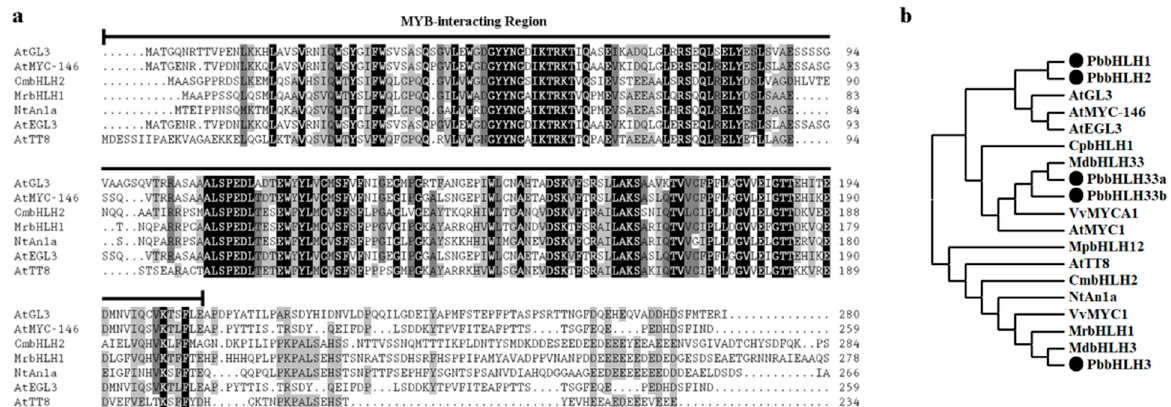
Figure 1. Analysis of IIIf bHLHs. ( a ) Multiple sequence alignment of the MYB-interacting region (MIR) domain of the IIIf bHLH transcription factors. Identical residues and conservative residues are marked in black and gray, respectively. The black line indicates the MIR. ( b ) Phylogenetic analysis of IIIf bHLHs from different species. The bHLH protein sequences of PbbHLHs were obtained from the NCBI. The gene accession numbers used are listed in Supplementary Table S1. At, Arabidopsis thaliana ; Cm, Chrysanthemum morifolium ; Cp, Chimonanthus praecox ; Md, Malus domestica ; Mp, Marchantia polymorpha ; Mr, Myrica rubra ; Nt, Nicotiana tabacum; Pb, Pyrus bretschneideri ; Vv, Vitis vinifera .